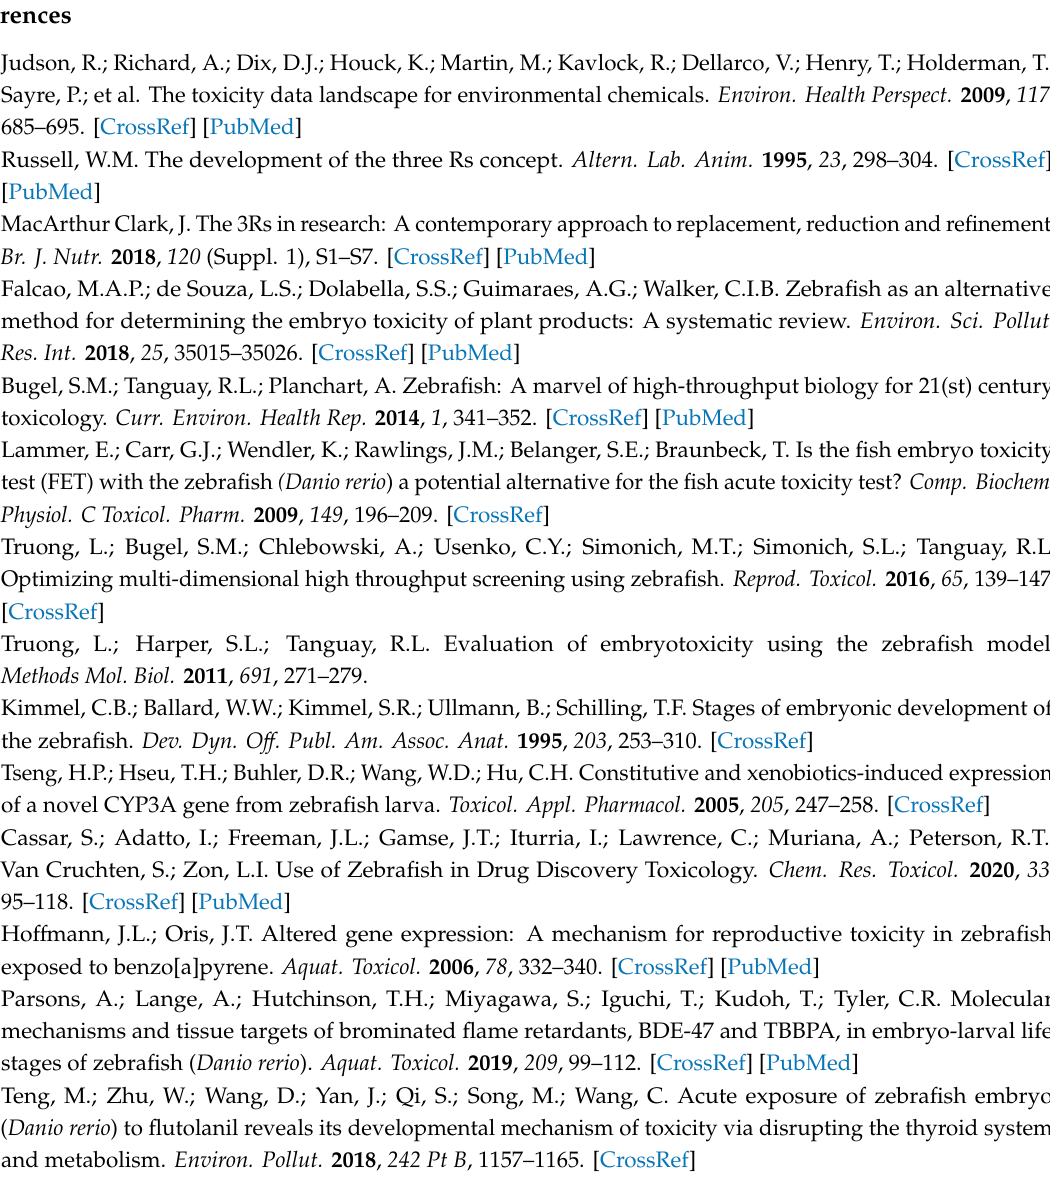
Table S3: LPR data for all test agent–condition combinations; Figure S3: plotted LPR response for all test agent–condition